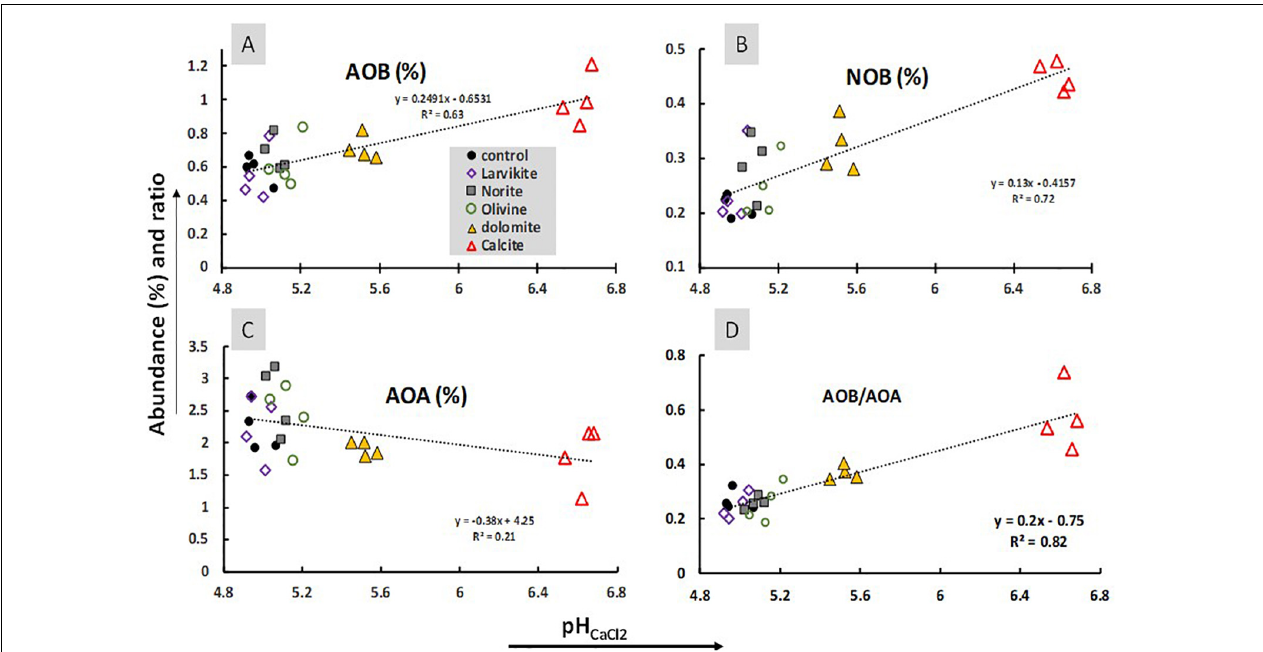
FIGURE 6 | The relative abundance (%) of nitrifying organisms as affected by soil pH. The figures show the relative abundance SSU rRNA copies (%) for AOB (A) , NOB (B) and AOA (C) , and the ratio between AOB and AOA abundance (D) ; all plotted against pH measured in 0.01 M CaCl 2 . Each point represents one individual field plot. The equation for the linear regression is included (all were significant, p < 0.05). The abundance of dominating groups within AOA and AOB are shown in Supplementary Table 4 . The N 2 O yield of nitrification in soil slurries (Y N 2 O . mol N 2 O-N per mol oxidized NH 4 + ) correlated strongly with the AOB/AOA ratio ( Supplementary Figure 7